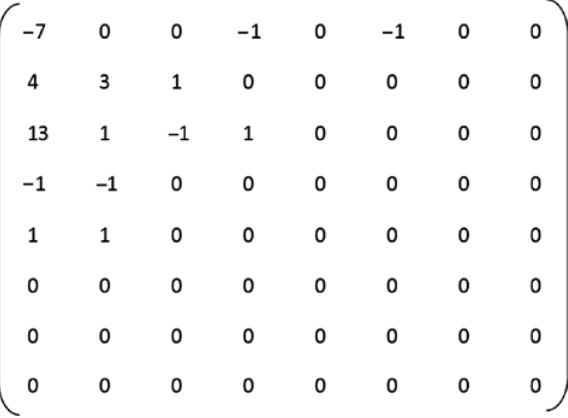
Figure 3: An Example of the Compressed Form of One Speech Signal